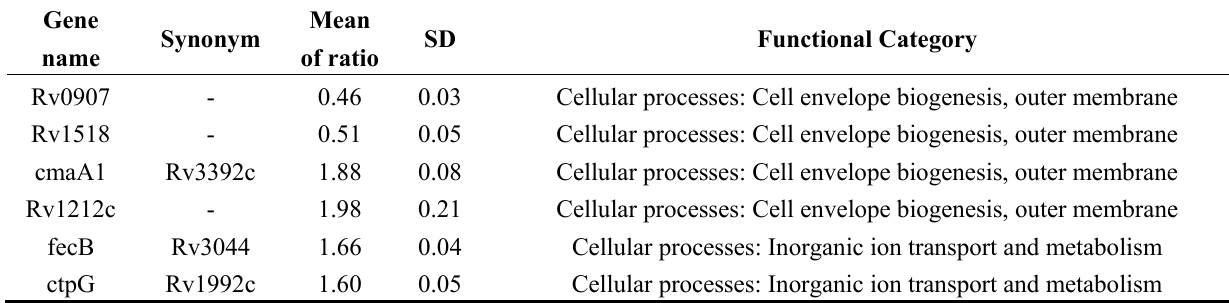
Table 2. Detection of number and functions of differentially expressed M. tuberculosis H37Rv genes induced by 4-deoxybostrycin with M. tuberculosis cDNA microarray and their functions.